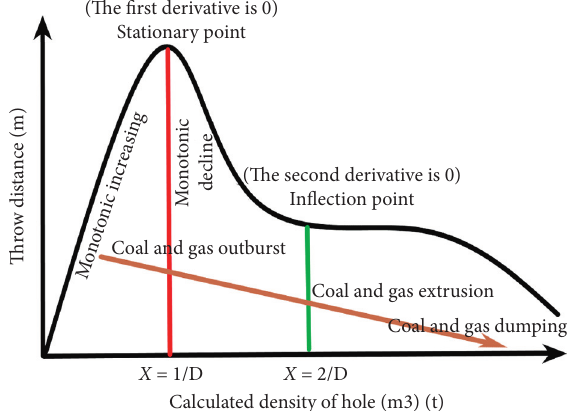
Figure 24: Conversion path of coal and gas outburst to pour out or press respectively. Slogistic1 and Slogistic3 are the best fitting Table 7. Different functions are used to fit the gas pressure curves, especially Slogistic3 ( x , a , b , k ), as shown in and CGOH volume. Four functions are appropriate, which Figures 25–28 and (18). are Lognormal, Boltzmann, Slogistic1, and Slogistic3,